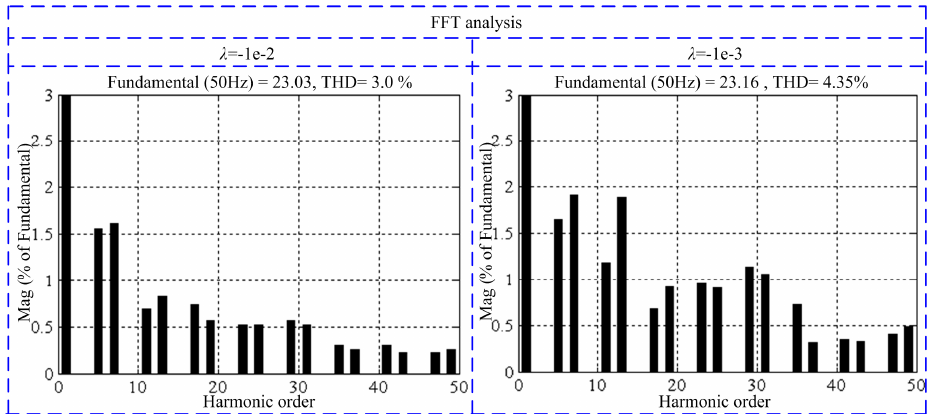
Figure 16. The FFT analysis of grid currents in steady-state condition. Table 3. Detailed experimental data.